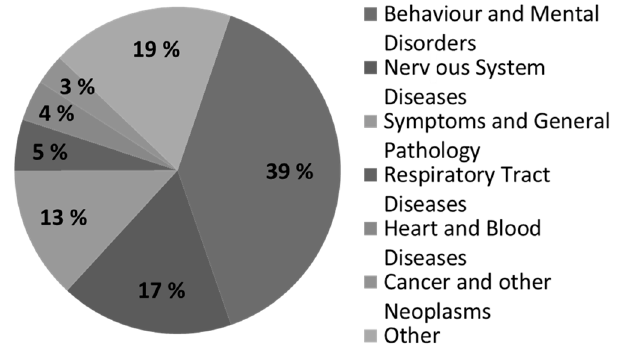
Figure 1. Actigraphy application area.